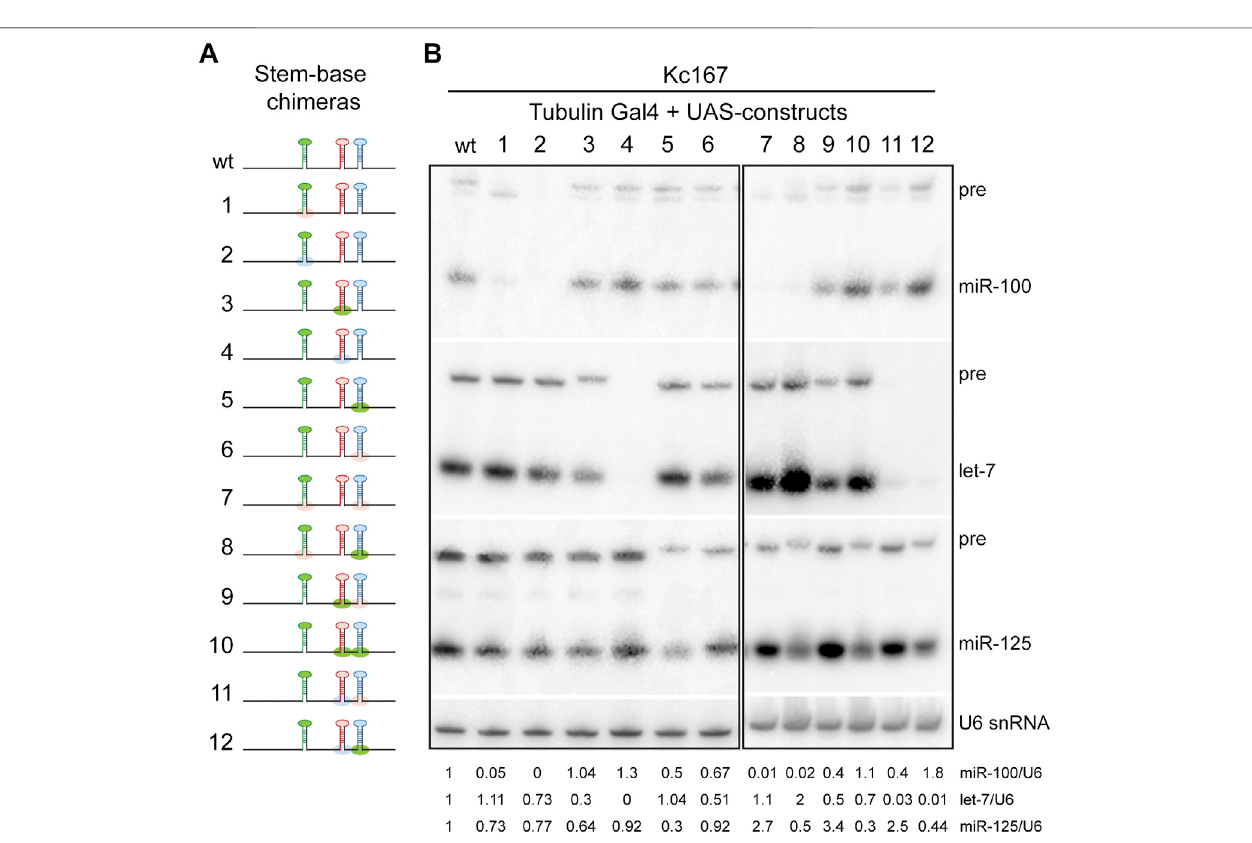
FIGURE 5 | Northern blot analysis of stem-base chimeras of primary let-7-C transcript. (A) Schematic of the UAS let-7-C constructs for determining the effect of stem base in processing of let-7-C miRNAs. (B) Northern blot analysis of transfected Kc167 cells probed for miR-100 (top panel), let-7 (middle panel) and miR-125 (bottom panel).Expressionplasmids (UAS constructs) wereco-transfected withTubulinGal4 plasmid andtotal RNAwasextractedafter 72 hoftransfection. U6 snRNA was used as a control for normalization (lowermost panel) and the normalized levels of processed miRNAs are indicated below the gel.